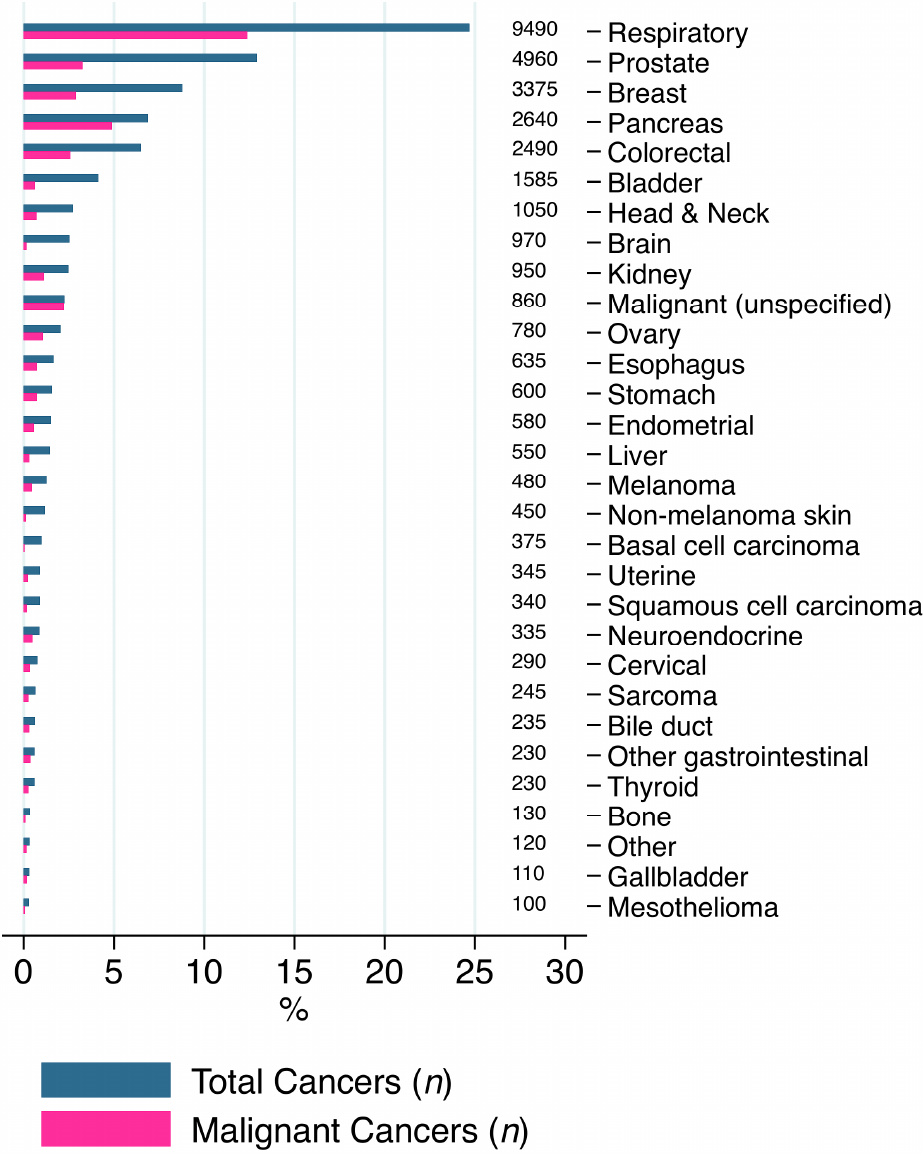
Figure 2. Distribution of each primary cancer type amongst the included sample of acute ischaemic stroke patients, representative of 1,106,045 patients.